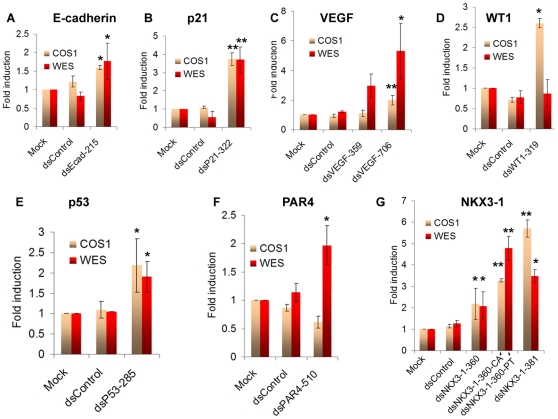
RNA activation of different genes in non-human primate cells.
A–G. COS1 and WES cells were transfected with 25 nM of the indicated saRNAs for 3–5 days. Mock samples were transfected in the absence of saRNA. mRNA expression levels were analyzed by real-time PCR and normalized to β-actin. Expression levels were measured as fold induction relative to mock transfections. The results are represented as mean ± SEM of three independent experiments. Species-specific saRNAs were designed to perfectly complement their respective chimpanzee (dsNKX3-1-360-PT) and AGM (dsNKX3-1-360-CA) targeted sequences in WES and COS1 cells, respectively. Statistical significance is indicated (* p<0.05, ** p<0.01) as compared to mock treatments.